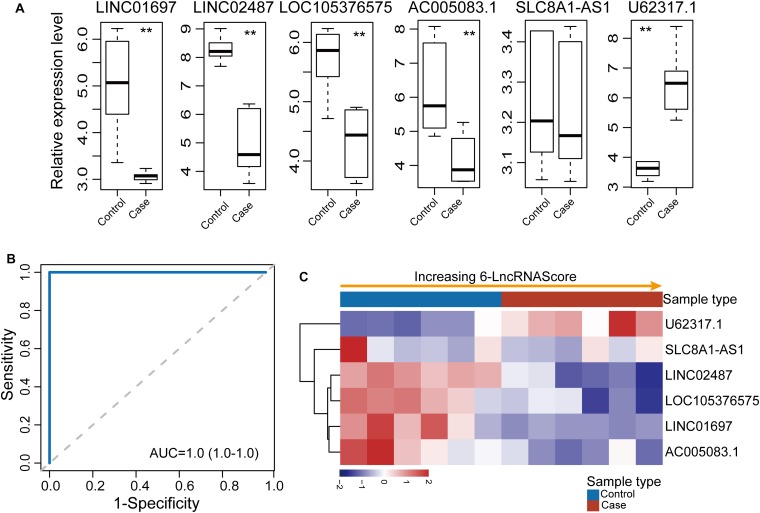
Further confirmation of the 6lncRNAScore in another GSE74530 dataset. (A) Expression patterns of six lncRNA biomarkers between OSCC samples and control samples. (B) Receiver operating characteristic (ROC) curves for 6lncRNAScore. (C) Expression heatmap of six lncRNA biomarkers of samples with increasing 6lncRNAScore. **p < 0.01.